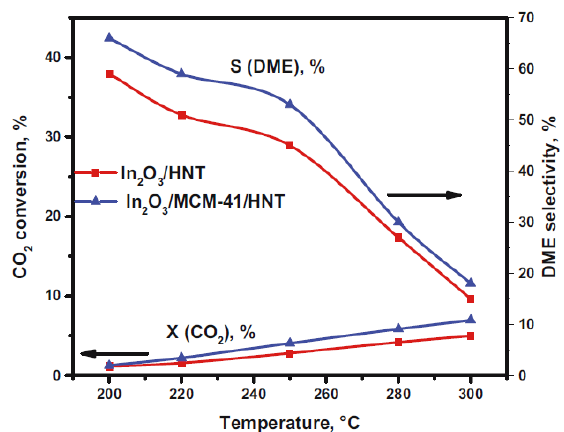
Figure 8. Catalytic performance over the In 2 O 3 /halloysite nanotubes catalysts at T = 200 – 300 °C, P = 4 MPa and GHSV = 12,000 mL·g − 1 ·h − 1 . Reproduced with permission from Pechenkin et al. [31], published by De Gruyter, 2021.